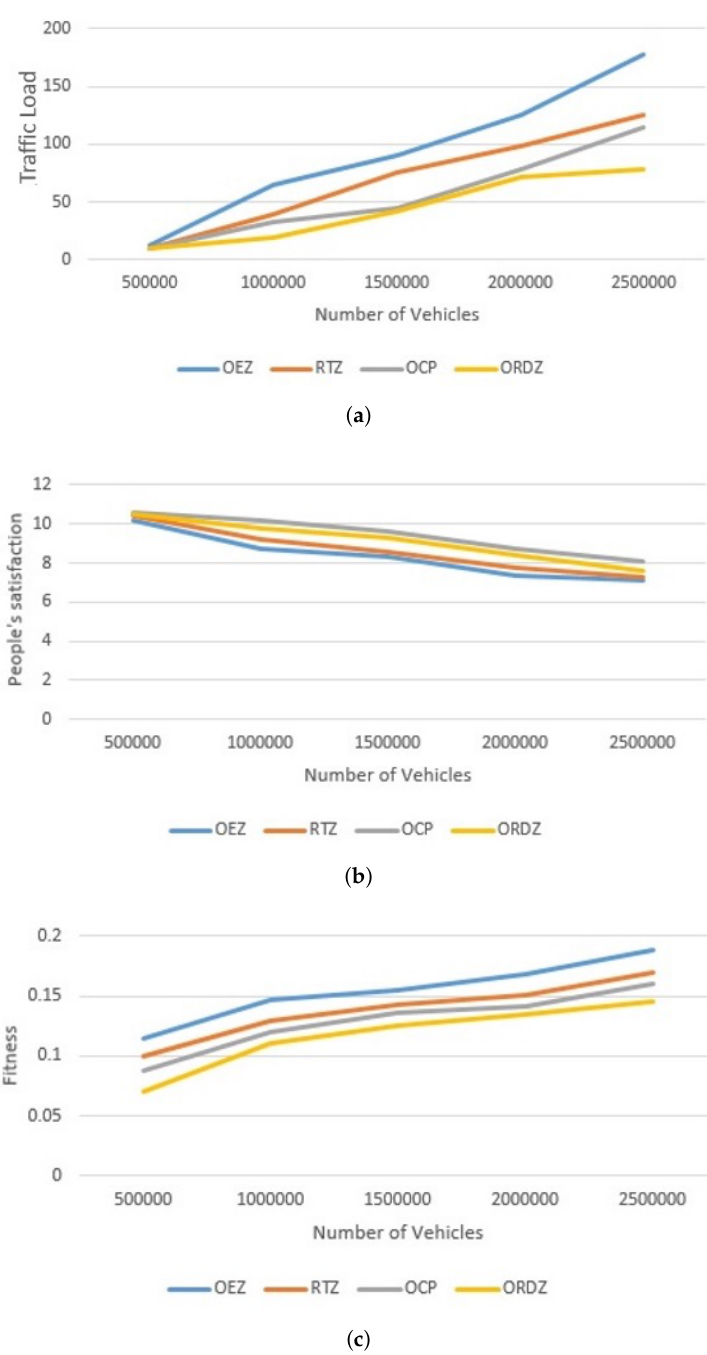
Figure 17. Comparison of different techniques based on: ( a ) impact of traffic load; ( b ) impact of citizen satisfaction; ( c ) compare fitness function for all